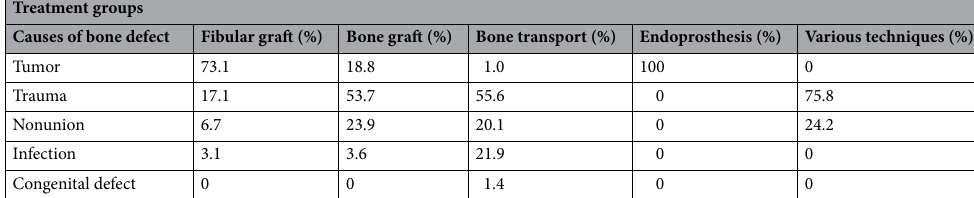
Table 2. Summary of bone defect causes.